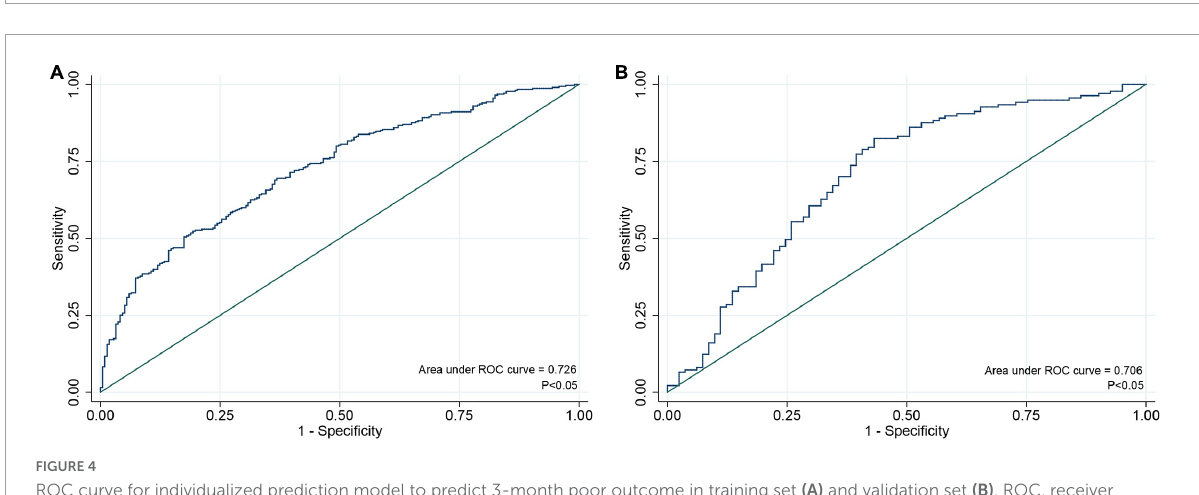
They induce an increase in acute phase response proteins, including globulin (Gabay and Kushner, 1999). Increased inflammatory cytokine levels in patients with acute ischemic